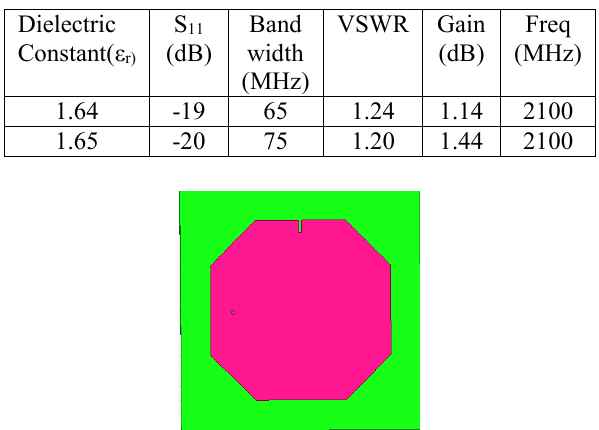
Fig. 1.7 Structure of Antenna 2 using HFSS